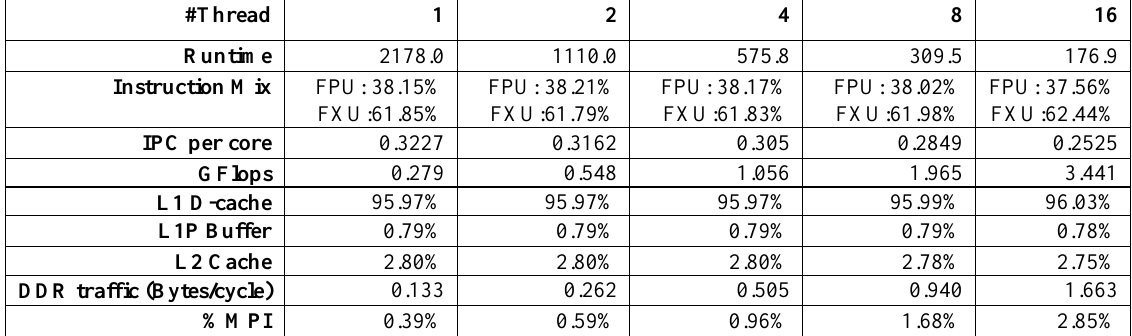
Table 6. Performance (per node) comparison of GTC on 128